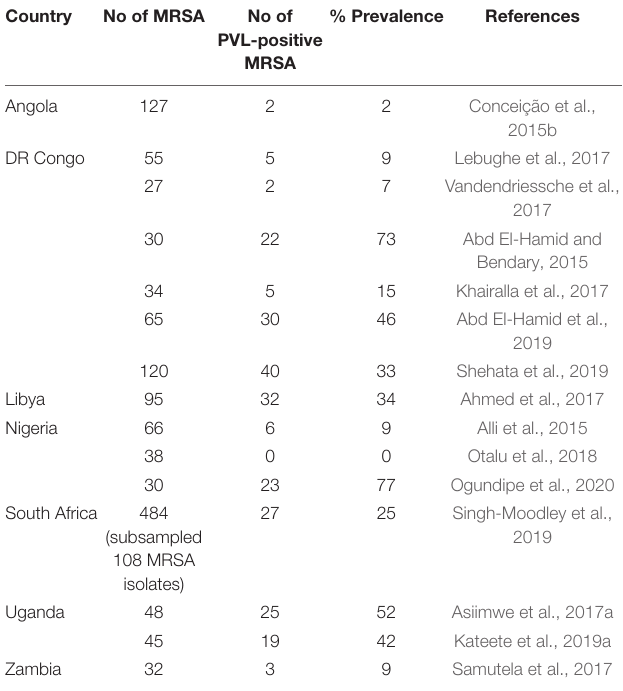
TABLE 2 | Prevalence of Panton–Valentine leukocidin (PVL) gene reported in eligible studies with ≥ 30 methicillin-resistant Staphylococcus aureus (MRSA)